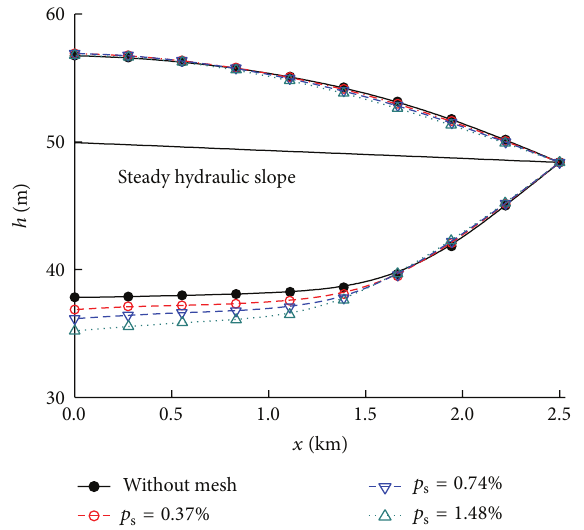
Figure 14: Extreme pressure distributions along the pipeline.